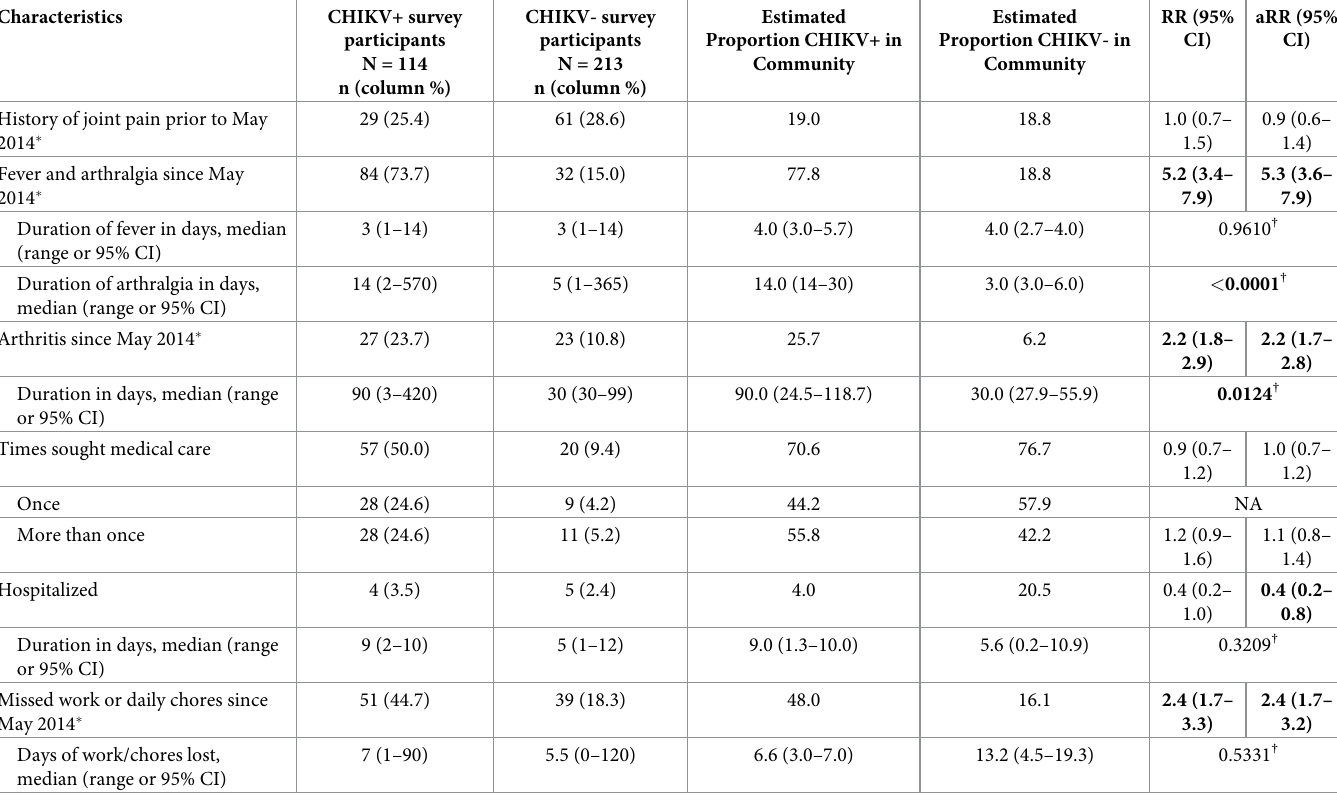
Table 4. Association of illnesses and disability with chikungunya virus infection among residents of four communities in Puerto Rico, November 2015–February 2016.